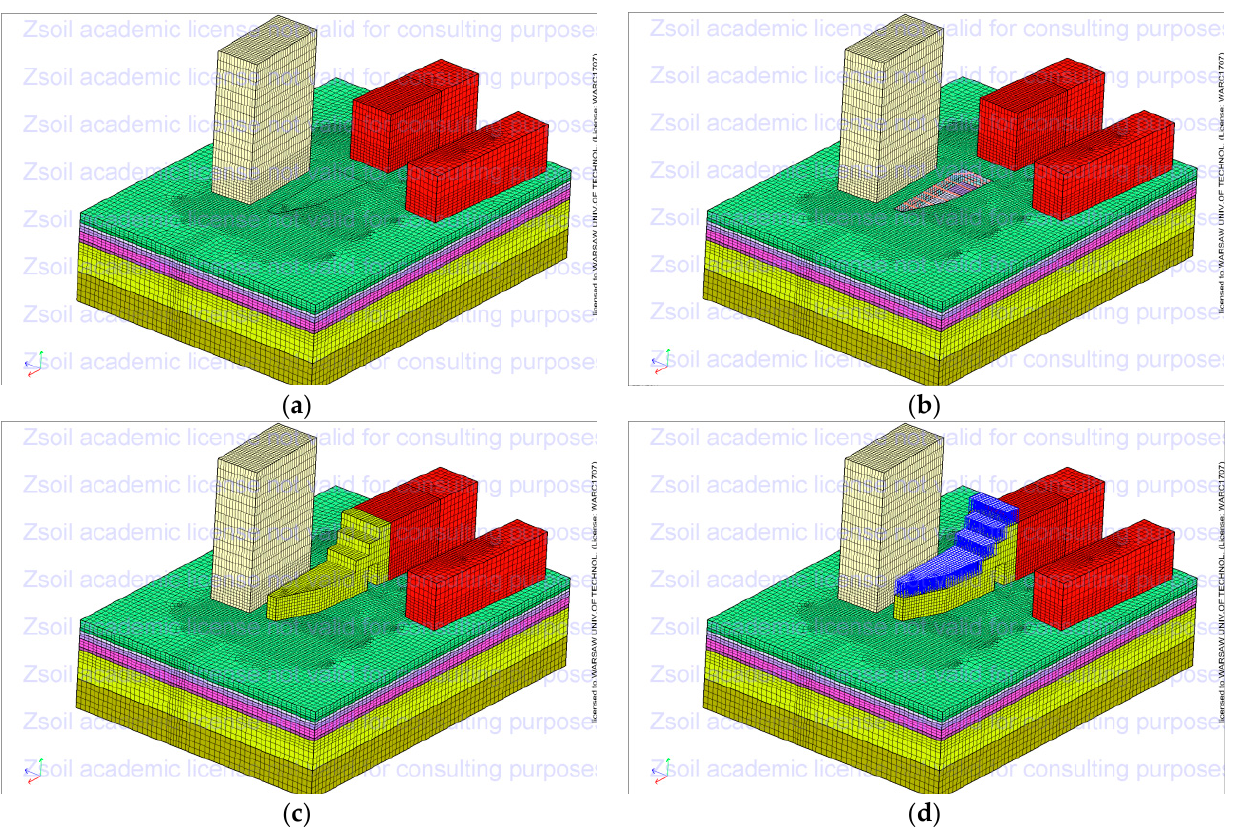
Figure 10. Results of geodetic measurements of vertical displacements (in mm) for benchmarks located on a high-rise building at 1B Ludna Street; benchmark Rp30 was stabilized on the western wall of the building at a distance 6.1 m from the wall of new building D; benchmark Rp27 was located at a distance 20.6 m away (see Figure 6). Source: own study based on (Korczak, P. Documentation of surveying Solec/Ludna/Wilanowska. Displacement measurements. Warszawa